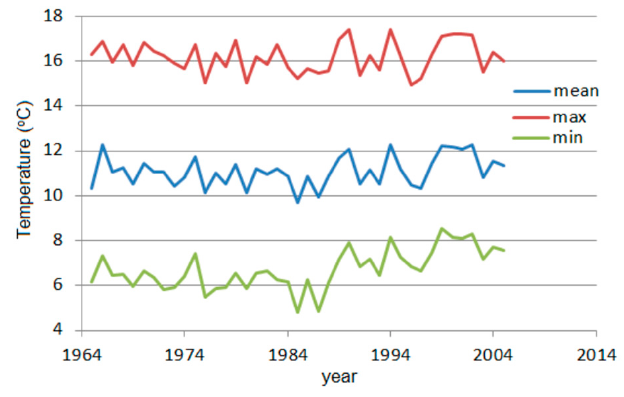
Figure 3. Minimum, maximum, and mean annual series. Table 1. Results of the Mann–Kendall trend test.